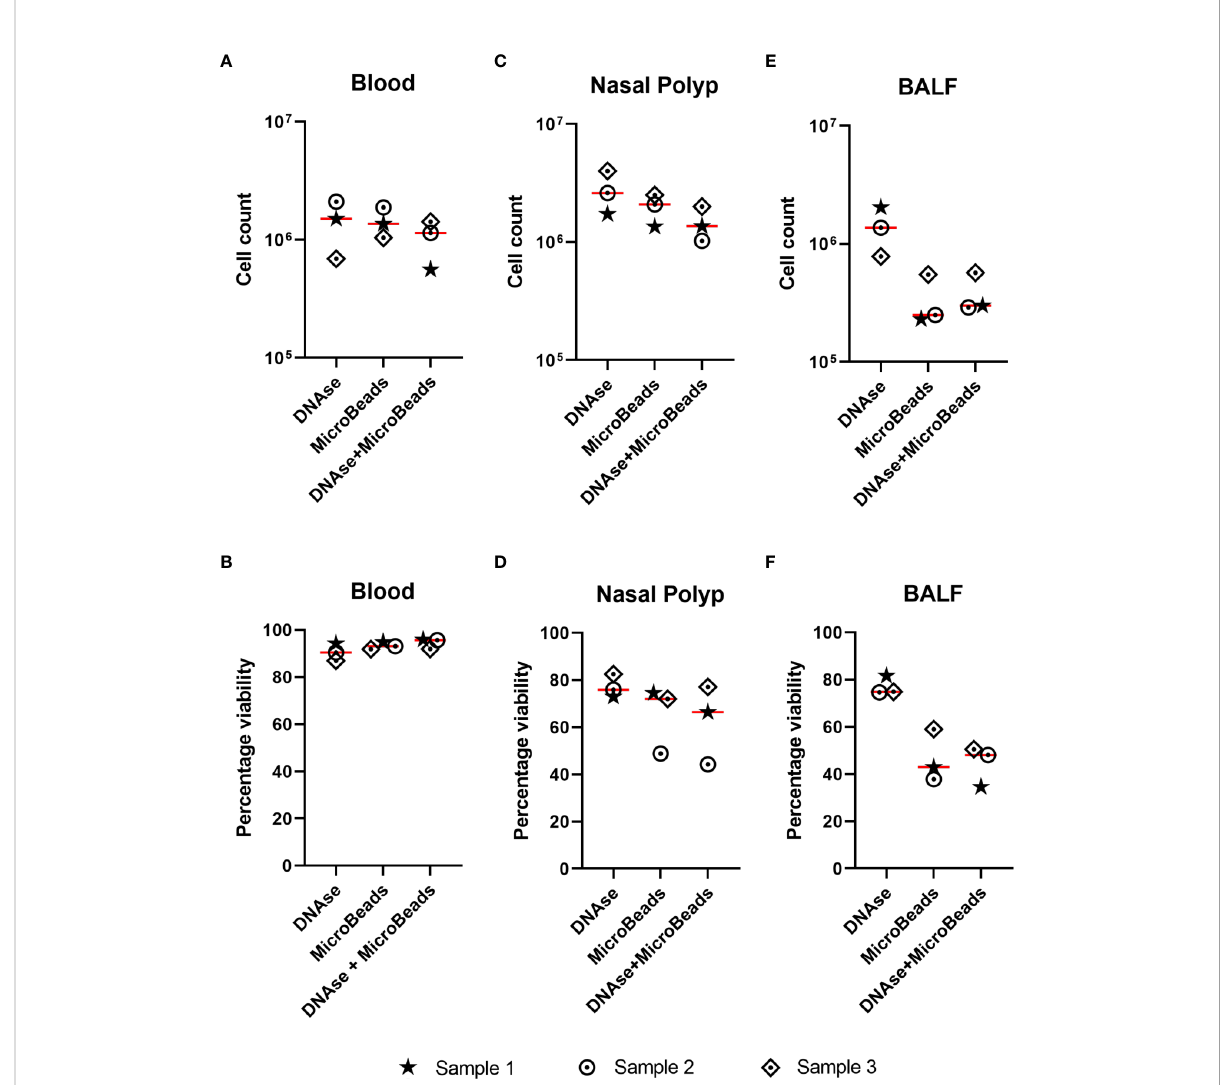
FIGURE 2 Effect of DNAse and/or microbeads on cell count and viability in different sample types. (A-F) Single cell suspensions were treated with either DNAse solution, Basic MicroBeads (Miltenyi), or combined DNAse solution + Basic MicroBeads (Miltenyi), prior to labeling according to Maxpar Direct Immune Pro fi ling Assay protocol. The upper graphs show the cell count after treatment for (total number, y-axis) (A) blood (B) nasal polyp and (C) bronchoalveolar lavage fl uid (BALF) and lower graphs show the percentage of cell viability upon acquisition (given in percentage, y-axis) for (D) blood, (E) nasal polyp, and (F) BALF using the three above mentioned treatments. Lines represent mean of three independent